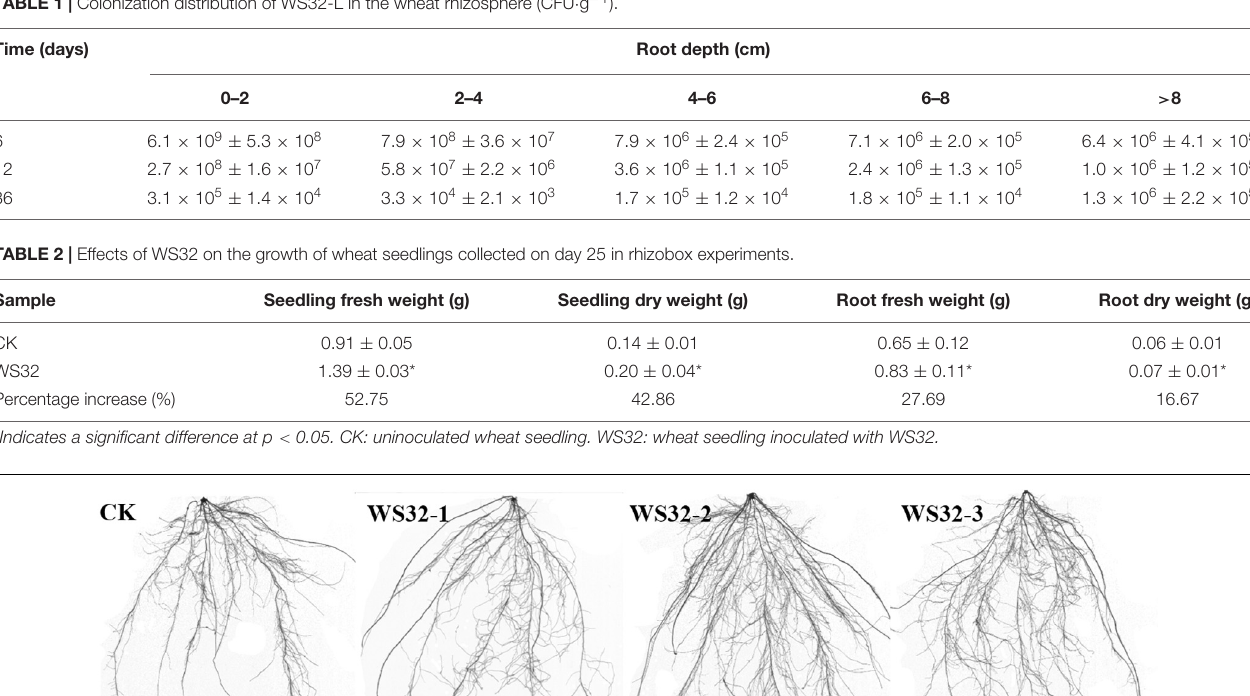
TABLE 1 | Colonization distribution of WS32-L in the wheat rhizosphere (CFU · g − 1 ).